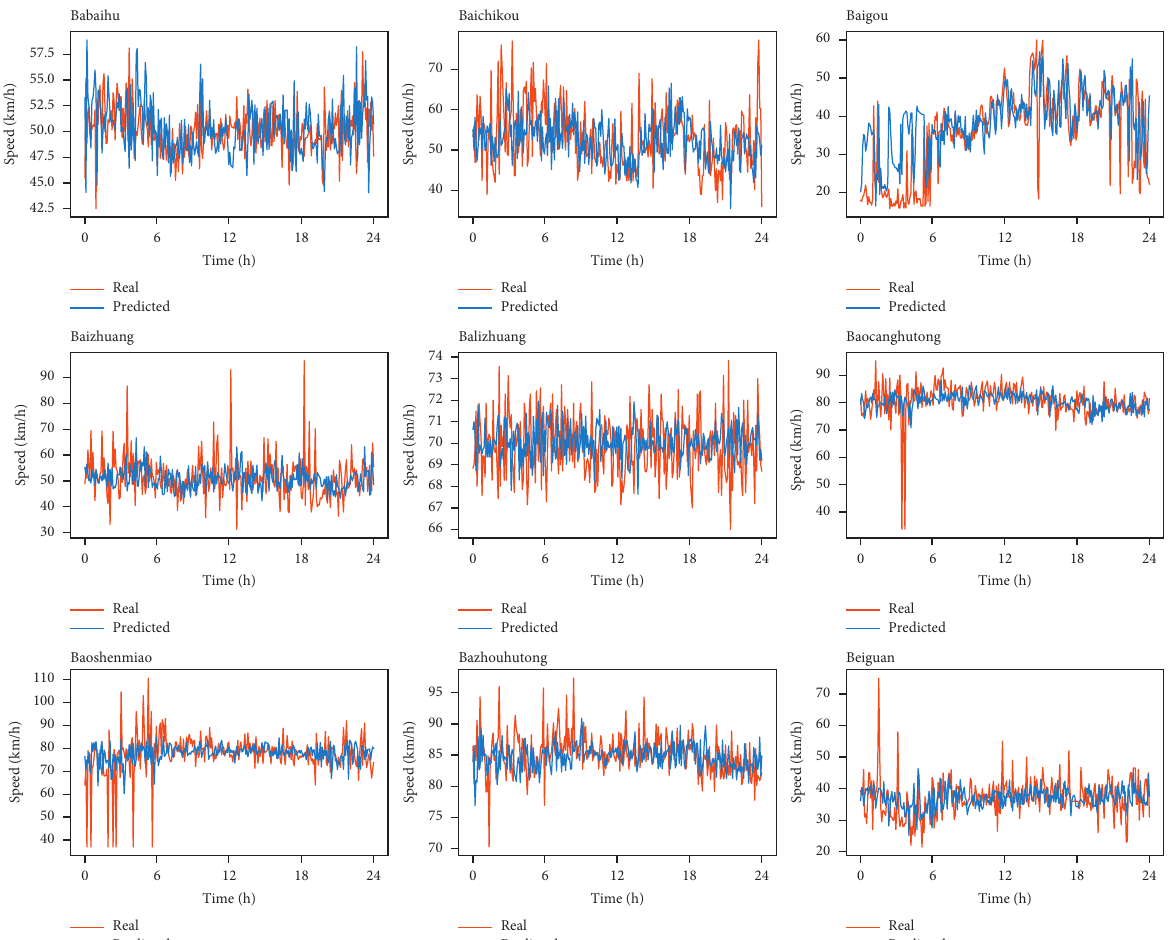
Figure 3: Comparison of predicted speed and true speed in 9 observation